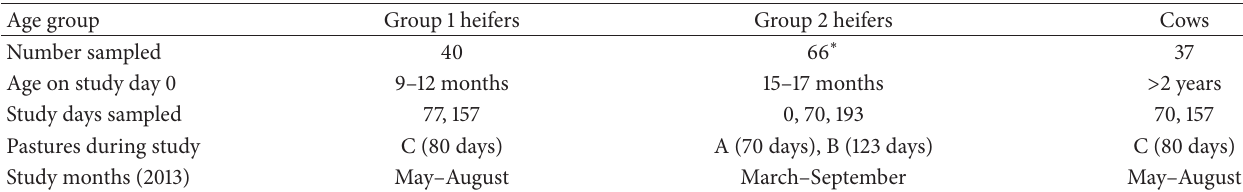
Table 1: Summary of descriptive characteristics for three cattle cohorts from a beef herd in California which were followed up for Anaplasma marginale